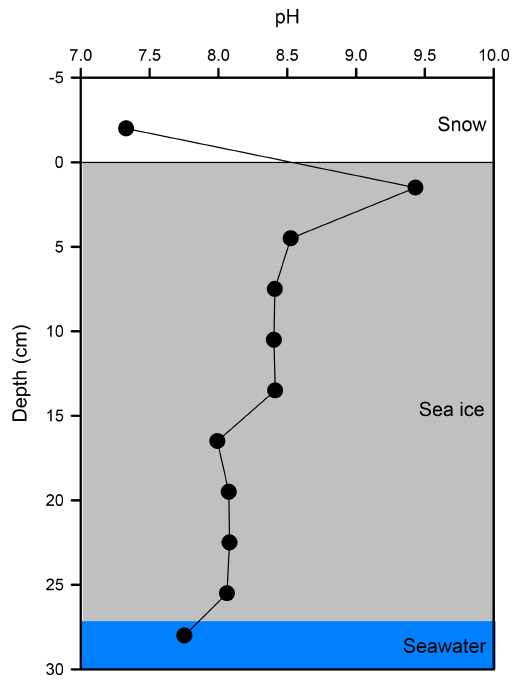
Figure 6. Vertical profile of pH across the snow–sea ice–seawater interface, as measured on the ice core taken on 21